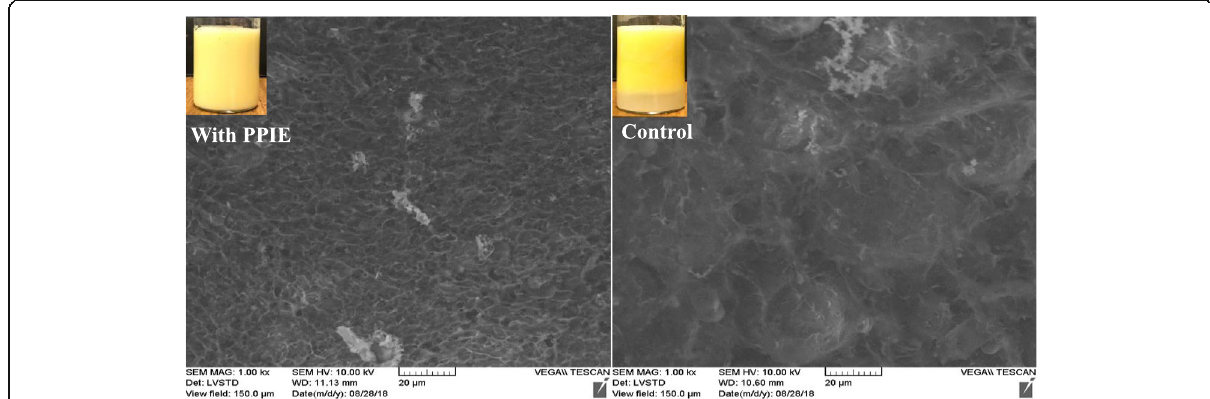
Fig. 5 Cryo-scanning electron microscope images of emulsion gels containing 1% PPIE and control (without PPIE); magnification: 1kx; scale bar = 20 μ m; PPIE: primary purified inulin extract from